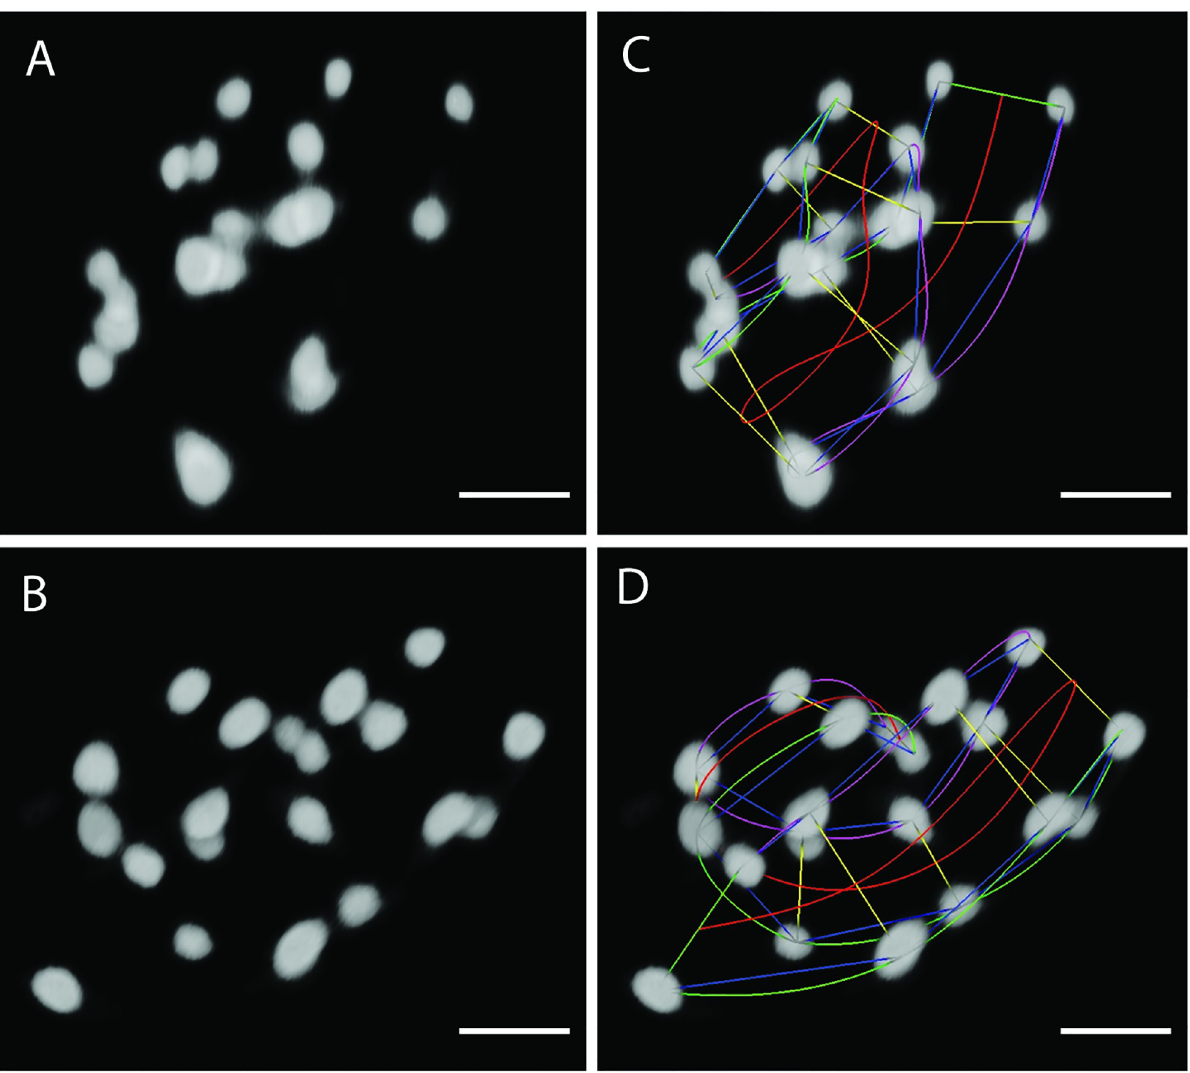
Fig 2. Manual posture identification in two successive image volumes of Fig 1B using MIPAV. The 20 fluorescently imaged seam cell nuclei rendered in two successive image volumes. Scale bar: 10 μm . A & B: Seam cell nuclei appearing in two successive image volumes visualized in MIPAV. The five minute interval allows the embryo to reposition between images, yielding entirely different postures. C & D: Manual seam cell identification by trained users reveals the posture. The curved lines are cubic splines as described in Fig 3C.